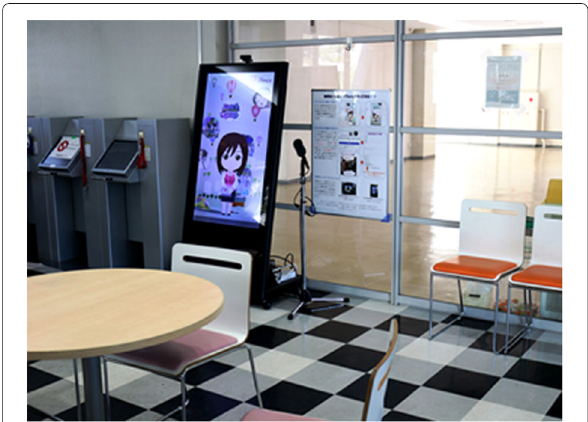
Fig. 13 Proposed system at Nagoya Institute of Technology